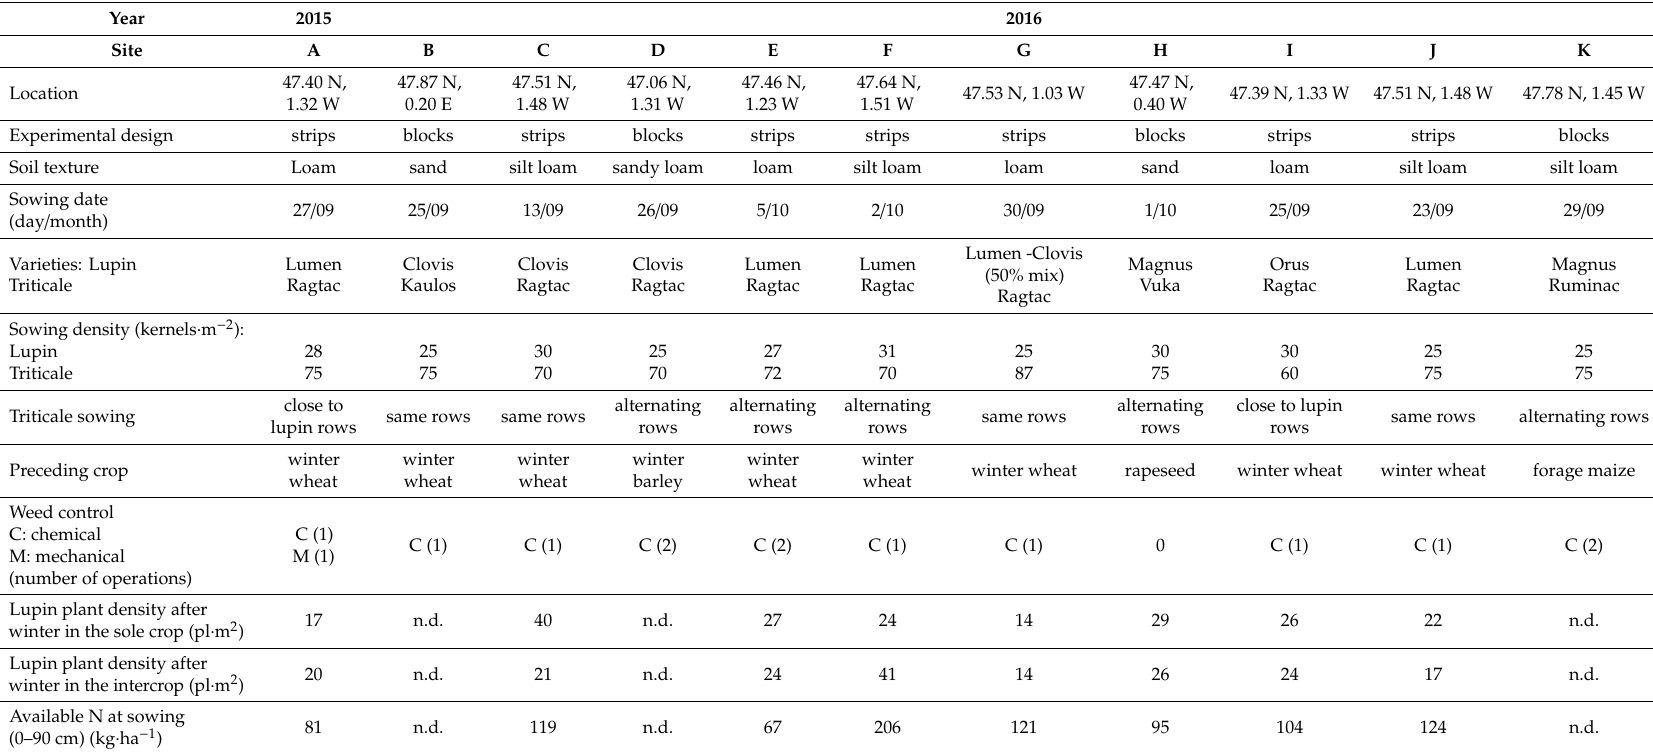
Table 1. Site details of the experimental